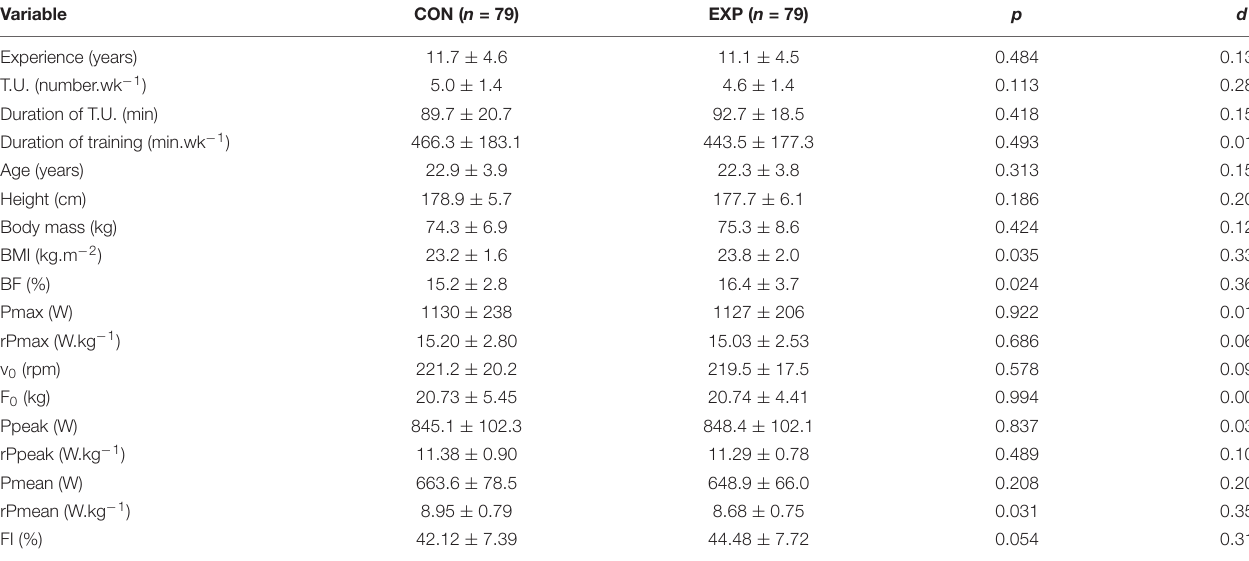
TABLE 2 | Training, anthropometric, and anaerobic characteristics in the experimental and control group. Variable